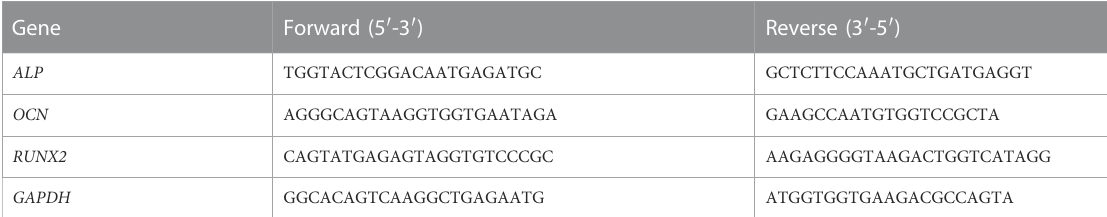
TABLE 1 Primers Used for Real-Time qPCR. Gene